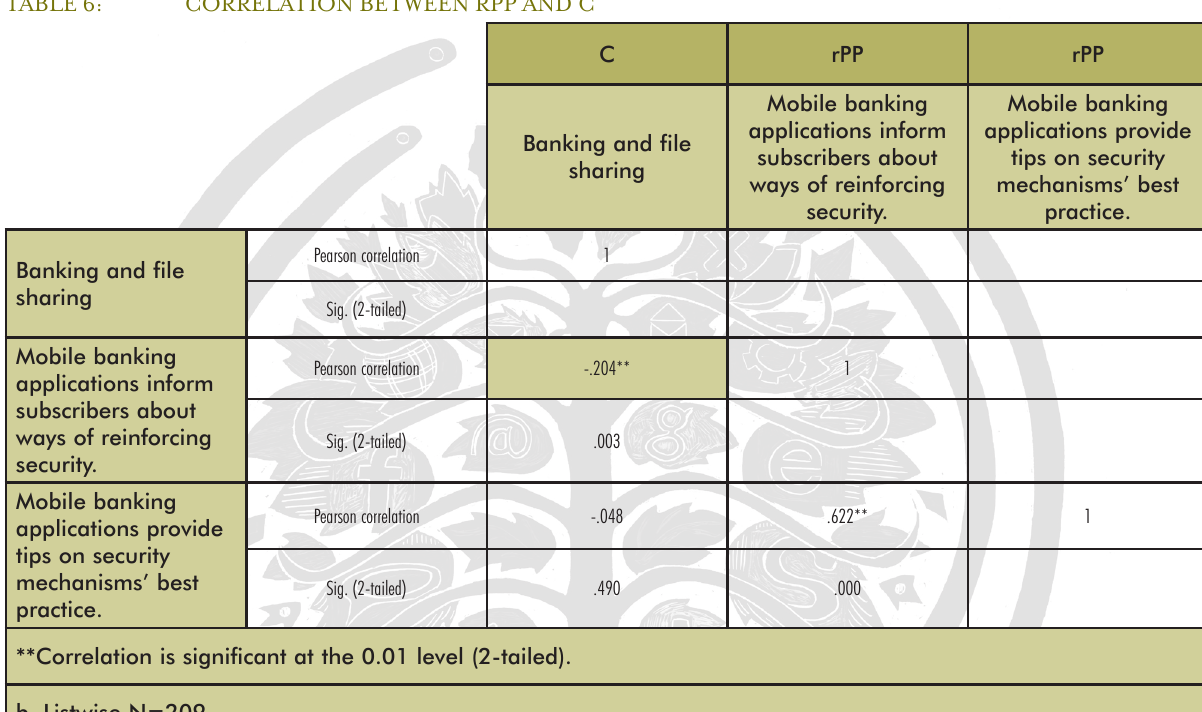
CORRELATION BETWEEN RPP AND C